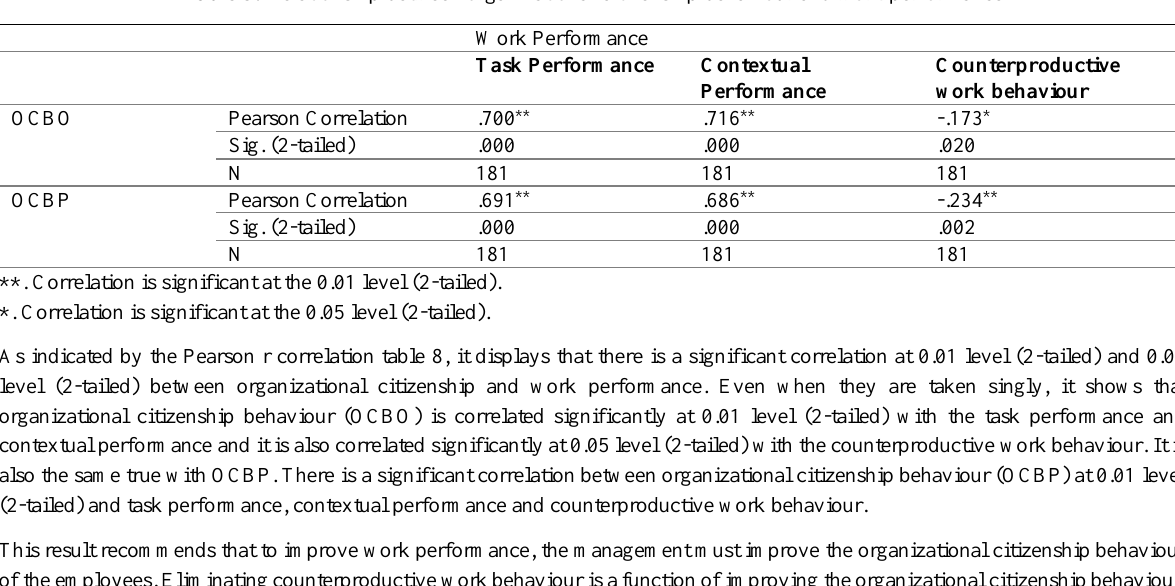
Table 8: Relationship between organizational citizenship behaviour and work performance